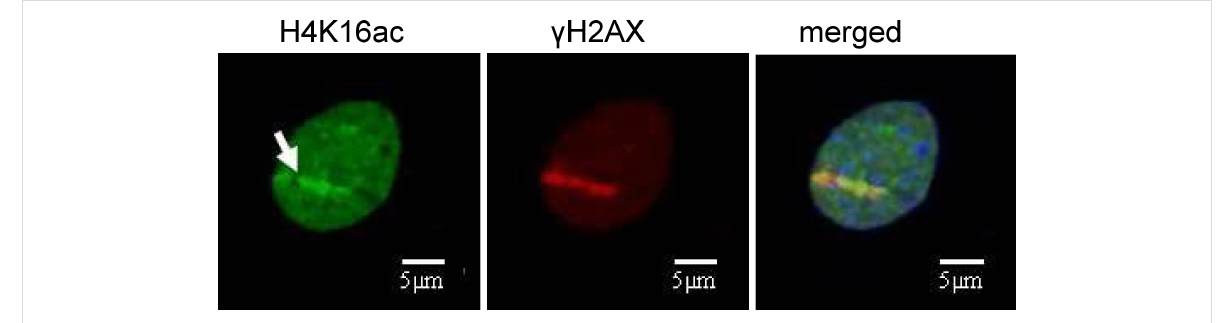
Figure 3: Accumulation of H4K16ac in mouse embryonic fibroblasts. Cells were irradiated with Au ions (energy: 8 MeV/n, linear energy transfer (LET): 13000 keV/ μ m; fluence: 3·10 6 ions/cm 2 ) at a low angle and fixed after 1 h. H4K16ac (green) is increased at damage sites. DNA damage is shown by γ H2AX staining (red). DNA is counterstained with ToPro3 (blue). From [12] – Copyright: GSI Helmholtzzentrum für Schwerionenforschung GmbH.